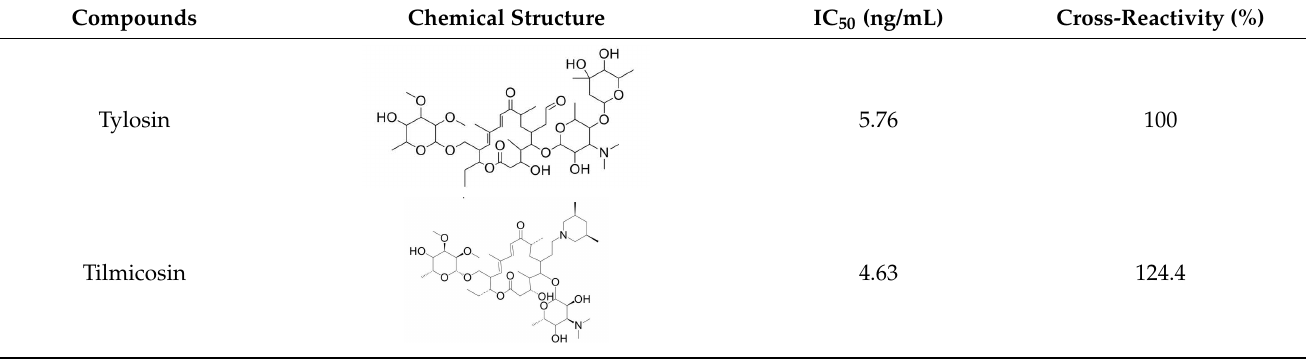
Table 2. CRs of related or similar compounds in the